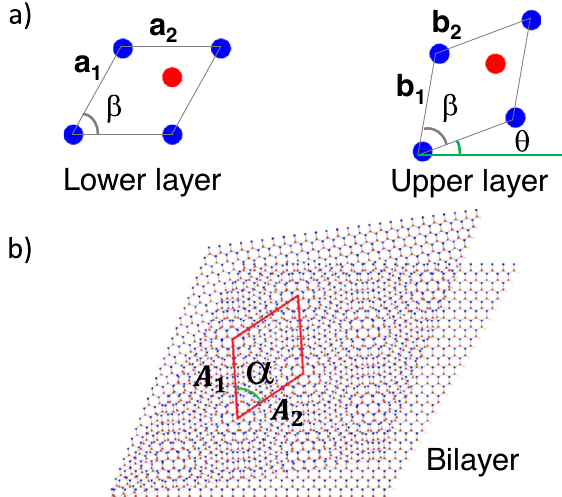
Fig. 1 Relevant parameters describing the moiré lattice formed by monolayers of hexagonal crystals, such as graphene and TMDs. a Sketch of the different TMD layers that compose the moiré lattice. The lattice parameters of the fi rst (second) layer are a 1 ( b 1 ) and a 2 ( b 2 ), the angle between those vectors is β for both layers, and the relative angle between the lattices is θ . b Moiré lattice parameters A 1 and A 2 and the internal angle α between those vectors in a bilayer formed by the hexagonal monolayer